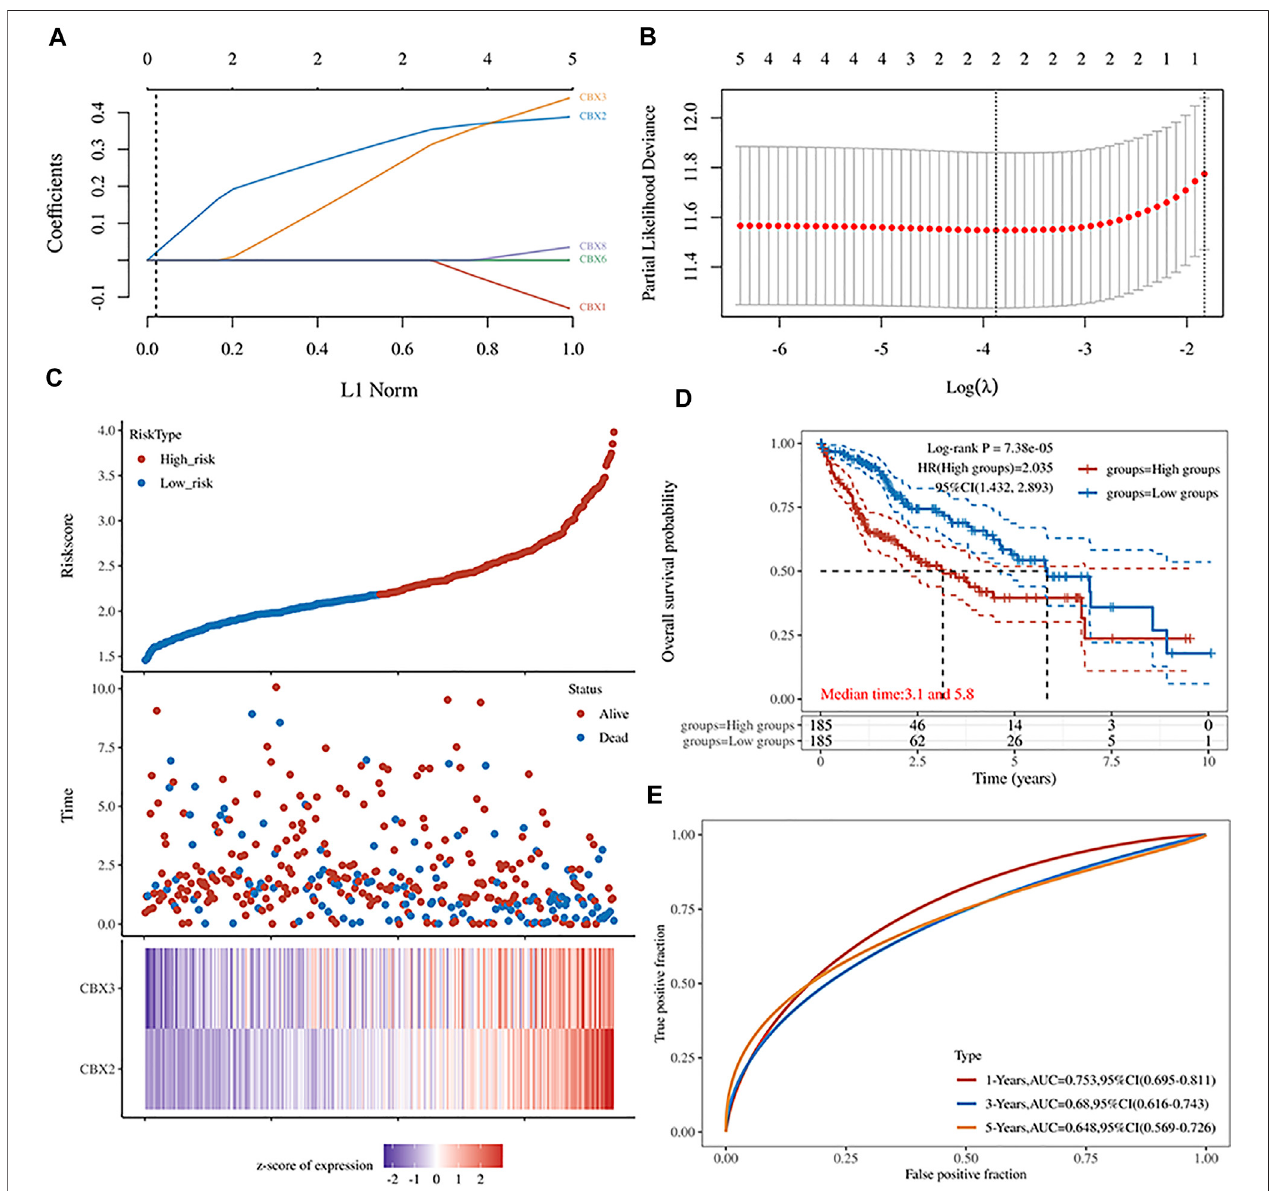
FIGURE 3 | (A) The fi ve CBXs ’ LASSO coef fi cient pro fi les (B) Plots of the cross-validation error rates tenfold. (C) Risk score distribution, survival status, and expression of fi ve prognostic CBXs in HCC (D,E) Overall survival curves for HCC patients classi fi ed as high- or low-risk, as well as the receiver operating characteristic (ROC) curve used to determine predictive